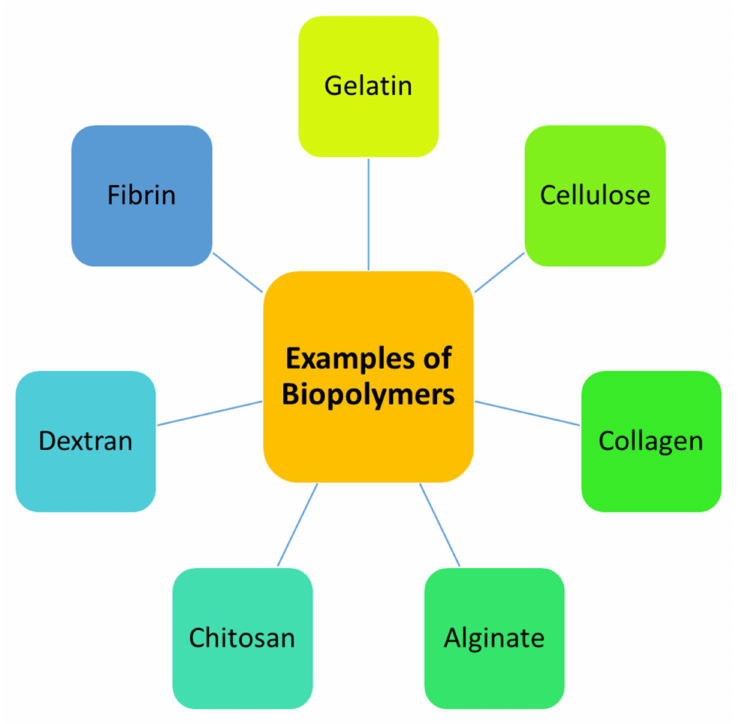
Figure 1. Examples of Biopolymers in Biomedical